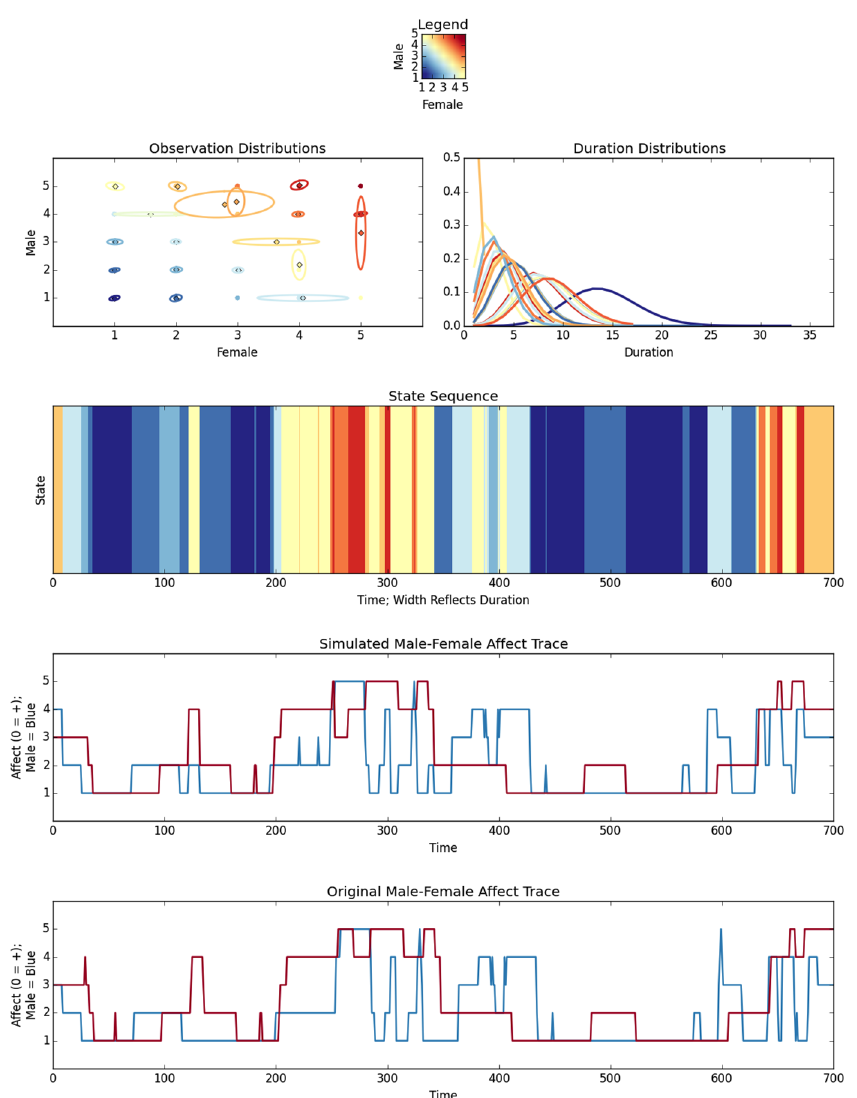
Fig 8. Simulated Distributions Of A Single Dyad From Cluster 1. The upper graphs show a simulated dyadic 2-d Gaussian of male and female joint affect and the simulated duration distribution. The middle graph illustrates the state sequence with durations indicated by band width. Positive affect is indicated by cooler, bluer colors. The final graphs show male-female interactions for simulated and original data,